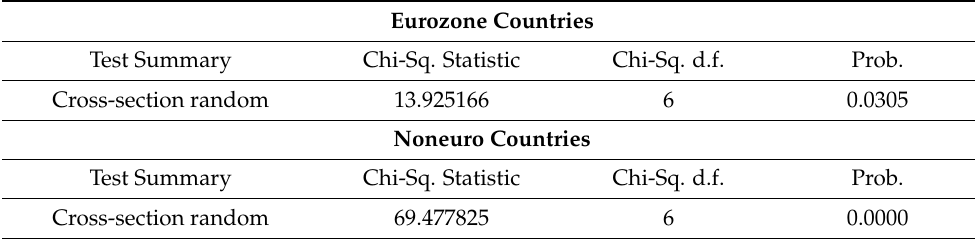
Table 10. The Hausman test (eurozone countries and noneuro